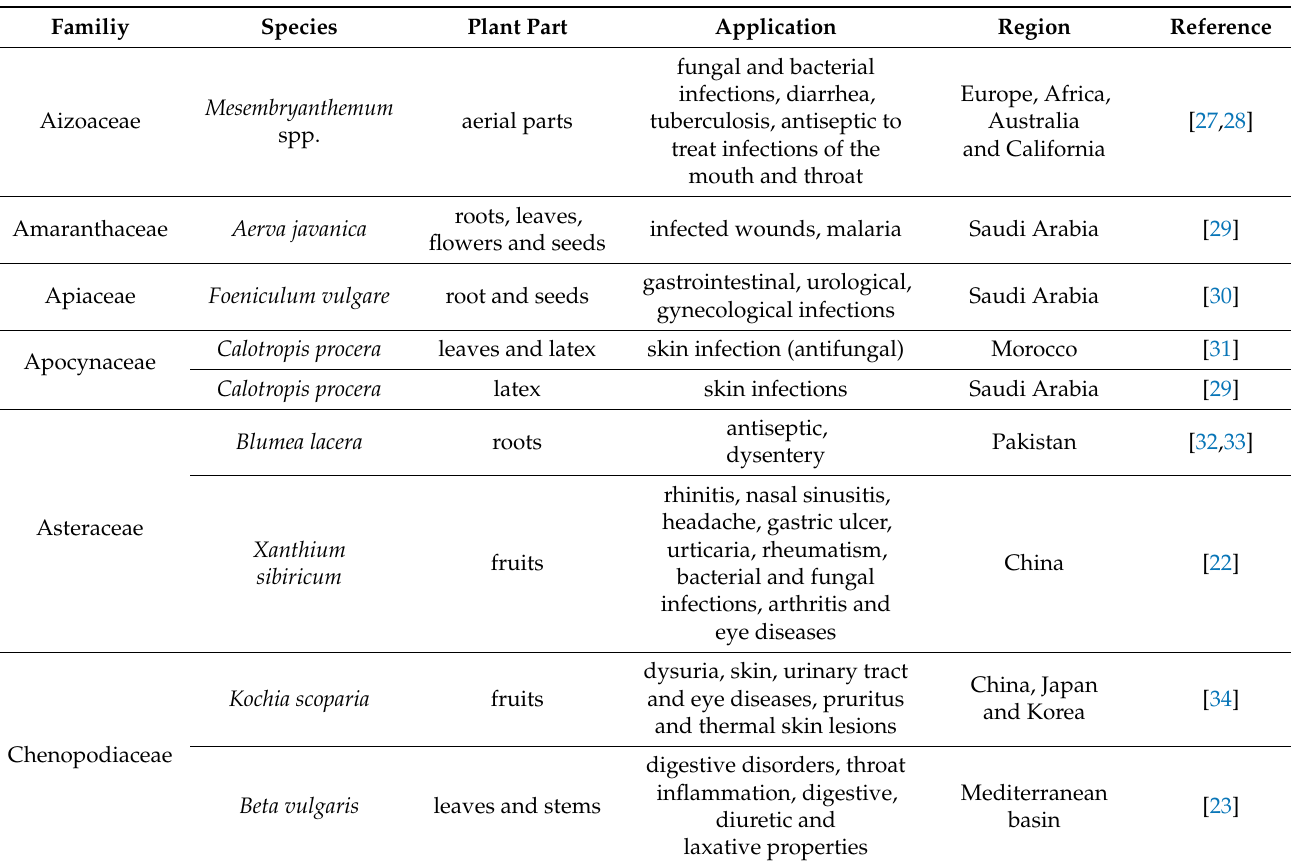
Figure 2. World distribution of halophyte habitats according to soil type (based on [25,26]). Mediterranean regions of Africa and Europe, the Arabian Peninsula, southwest Asian countries such as Pakistan, India and Afghanistan, and east Asian countries such as China and Thailand have a millennial history of using halophyte species as traditional medicines to treat or relieve symptoms of infectious and noninfectious diseases (Table 1). Table 1. Most common taxa of halophyte families used in traditional medicine and most frequent applications .